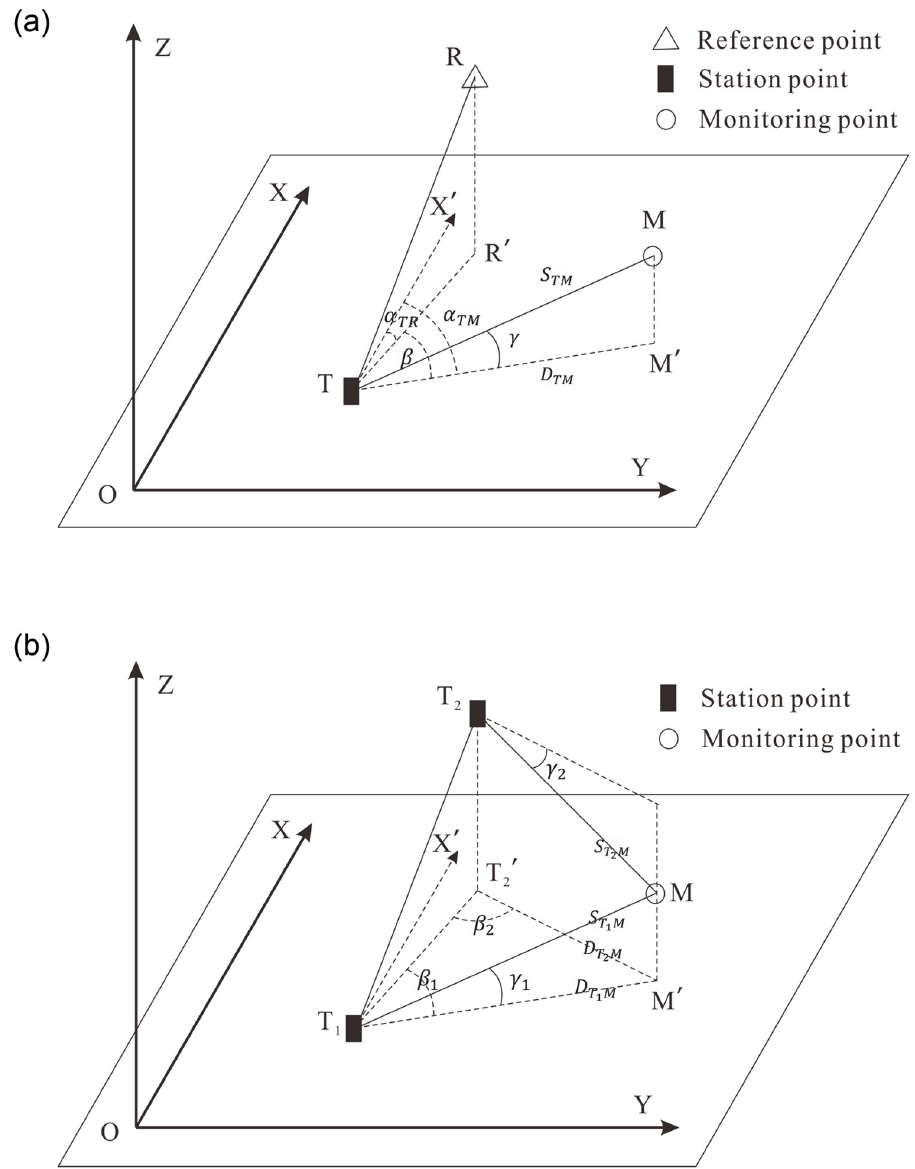
Fig 2. Dam deformation monitoring principle for plane coordinates with total station. (a) Polar coordinate method. (b) Forward intersection method.